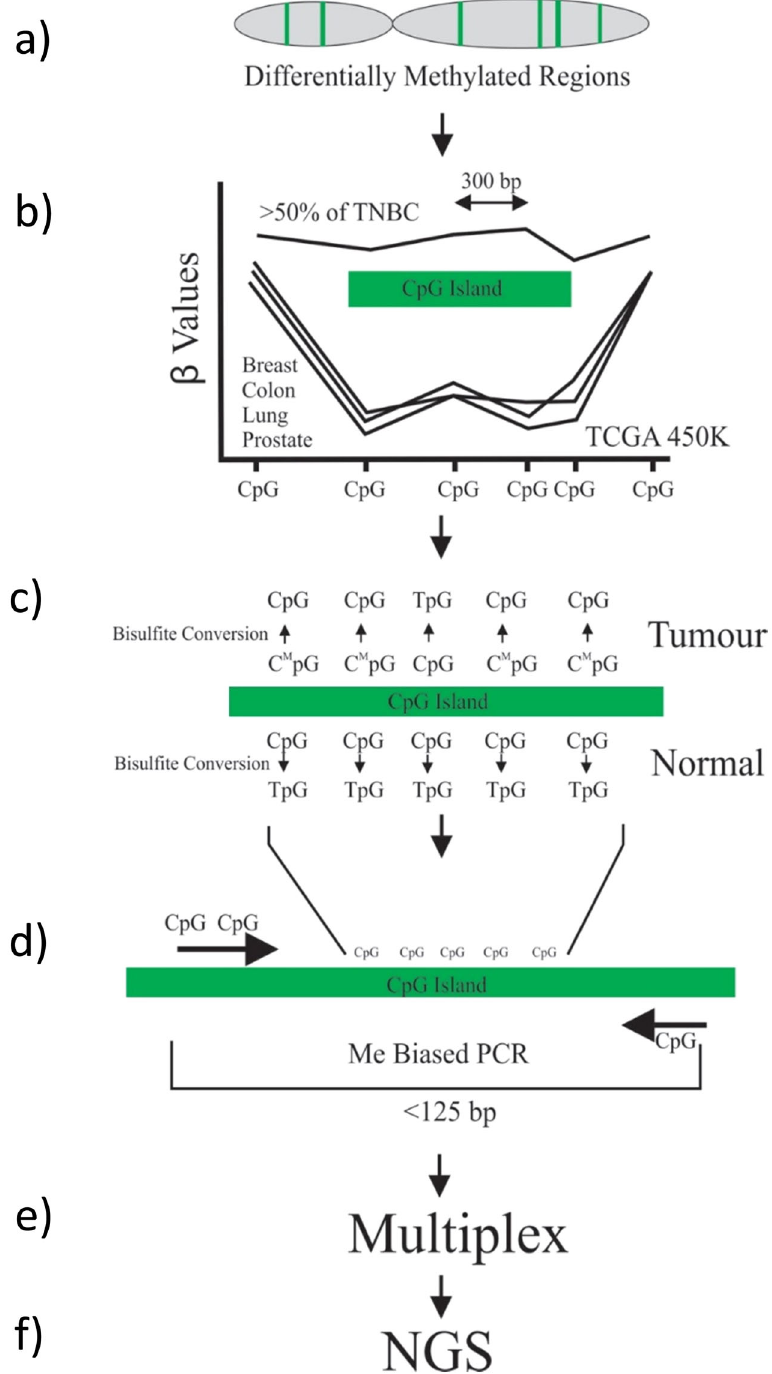
Fig. 1 Overview of the mDETECT assay. a mDETECT relies on the blood-based detection of large numbers of differentially methylated regions that are speci fi c to tumours represented by the green stripes on the grey chromosome. b To identify these regions with a high density of tumour-speci fi c methylation, those CpG dinucleotides found to show high levels of methylation in the tumour populations but low levels in the normal tissues were identi fi ed as being differentially hypermethylated. β -values represent methylation levels at a given probe (CpG dinucleotide). c Bisul fi te conversion of the DNA samples of these differentially methylated regions allows the multiple CpG residues in each region to be assessed and subsequently allows for differentiation between tumour and normal samples. d Methylation biased primers, as indicated by the arrows, are designed to preferentially but not exclusively amplify methylated DNA. This ensures that small amounts of methylated tumour DNA are ampli fi ed even in a high background of normal DNA. These PCR “ probes ” are designed to amplify products less than 125 bp (<125 bp) due to the highly fragmented nature of ctDNA ( e ). PCR is carried out by various types of multiplexing. f Next-generation sequencing (NGS) is carried out to identify multiple CpG dinucleotides that were methylated and to allow for high-level